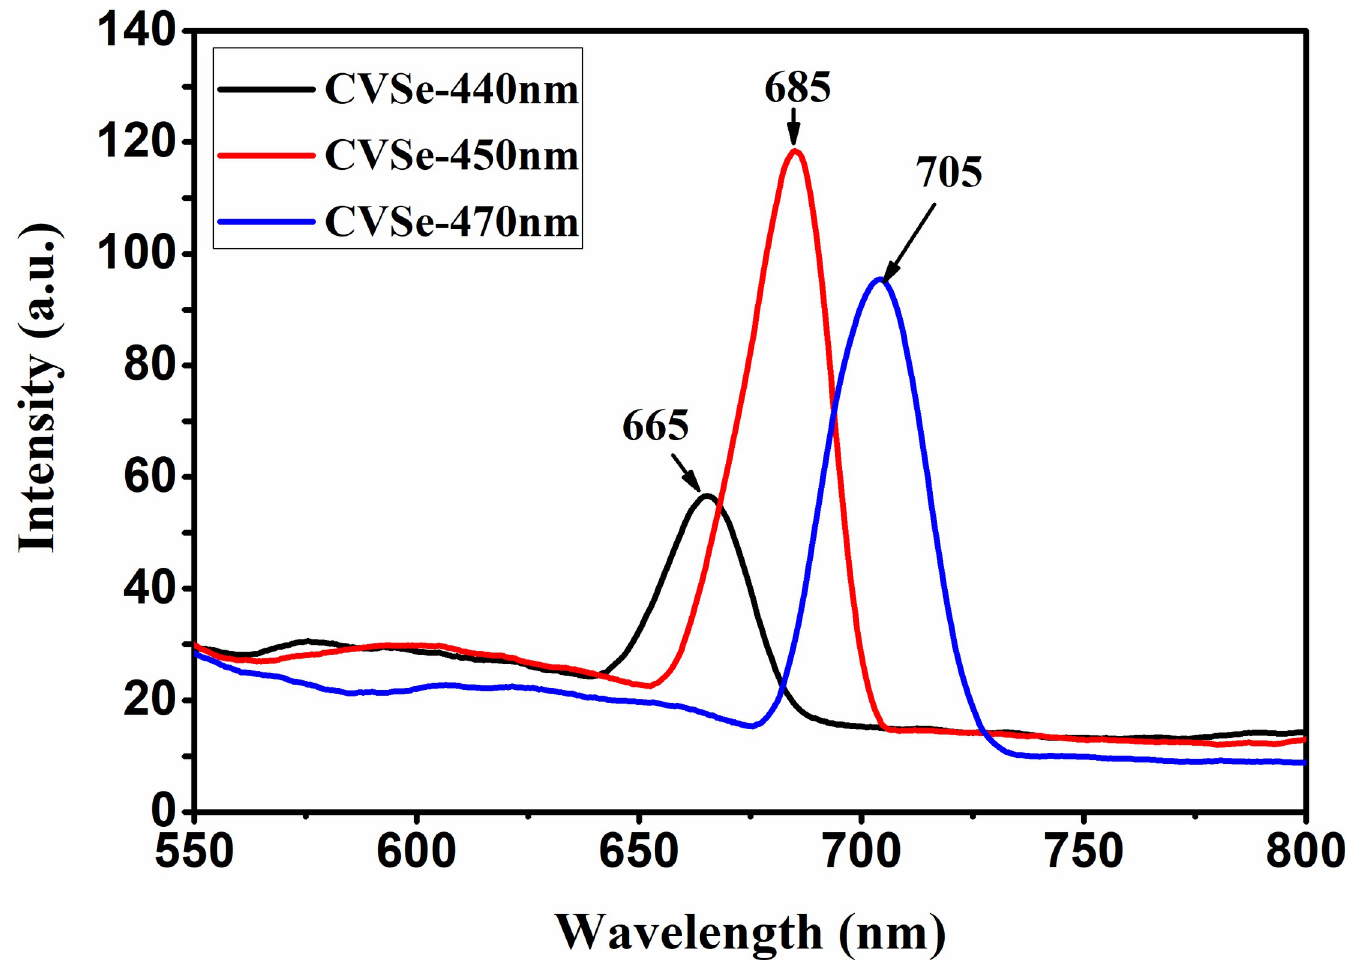
Fig 5. The photoluminescence (PL) spectra of synthesized CVSe NCs using different excitation wavelengths.